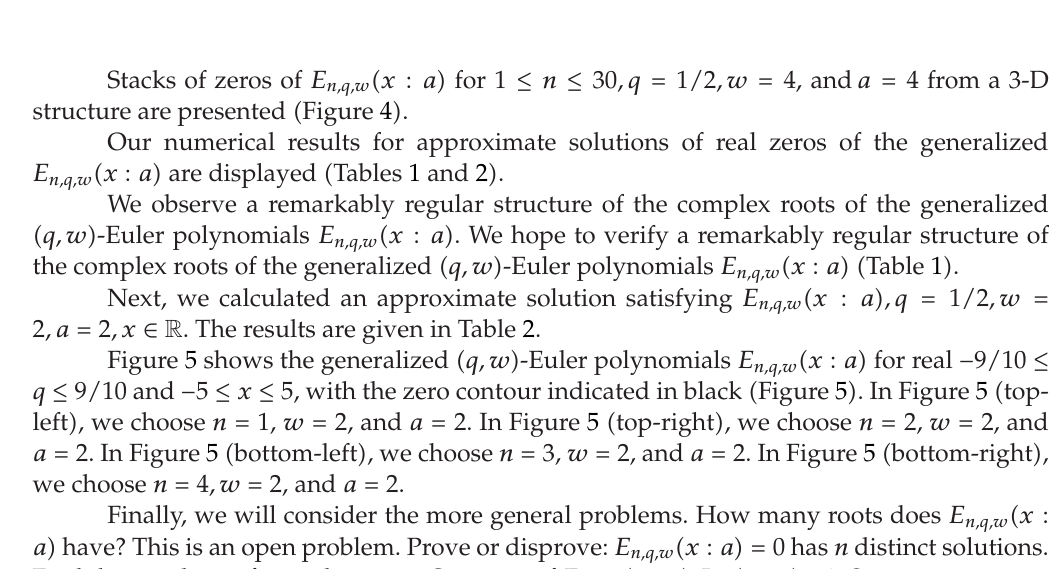
Figure 1: Zeros of E n,q,w (cid:2) x : a (cid:3) for a (cid:6) 1 , 2 , 3 ,